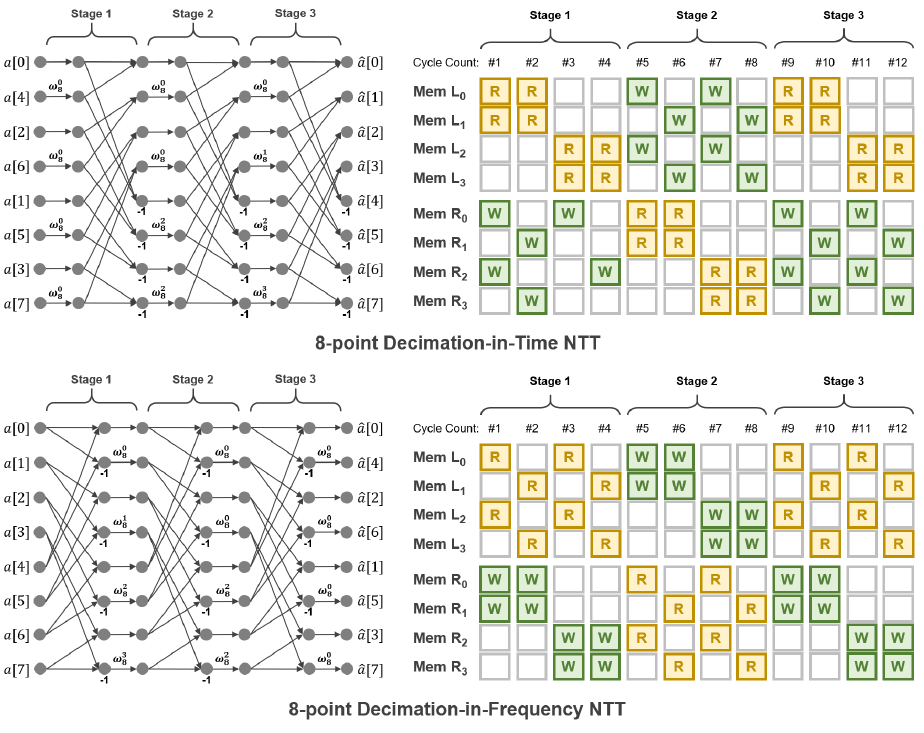
Figure 7: Memory access patterns for 8-point DIT and DIF NTT using our single-port SRAM-based memory architecture (R and W denote read and write